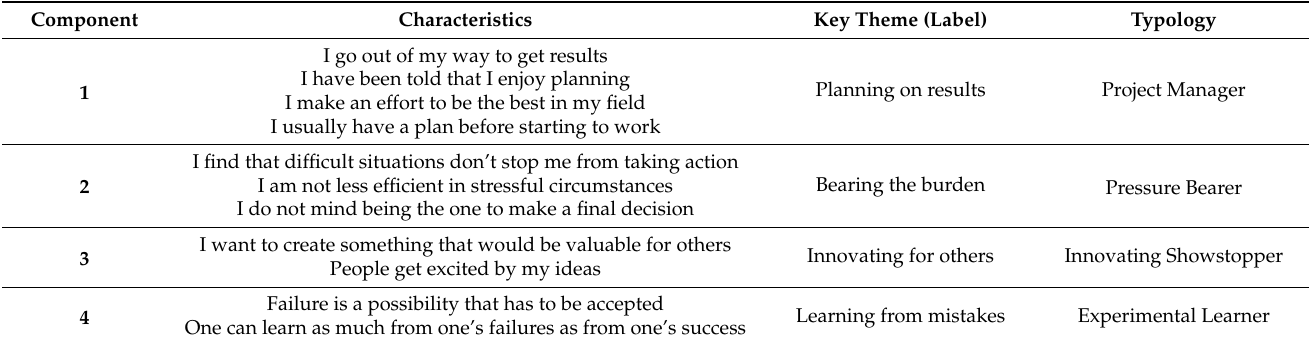
Table 4. Groupings of entrepreneurial